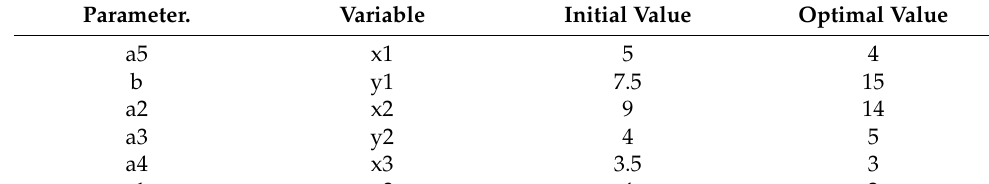
Parameter. Parameter.